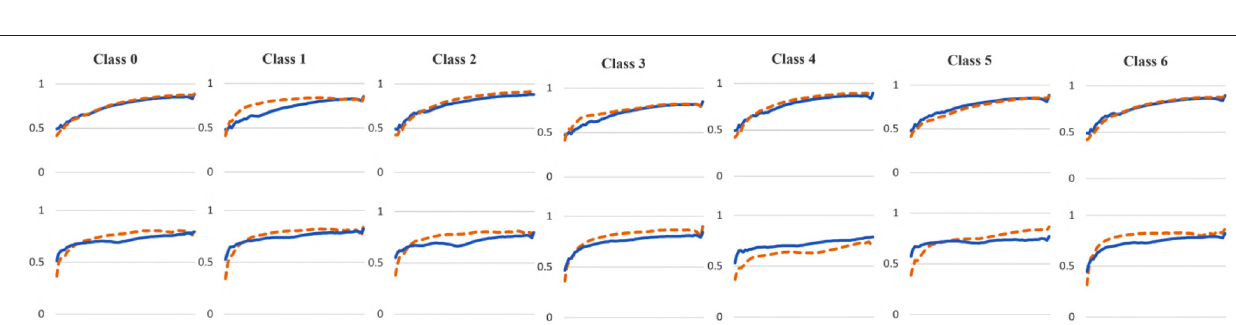
FIGURE 9 | Comparison of the Cut Position (Layer) VS SSIM cut curve for different classes of the ResNet-50 (blue), and ResNet-50-10 % (orange) models for (top row) Weedling and (bottom row) Plant Village